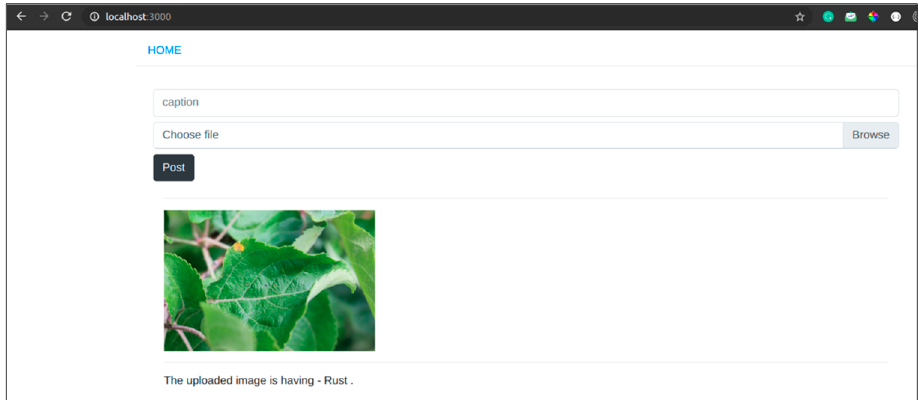
Figure 26. Snapshot of the web application.